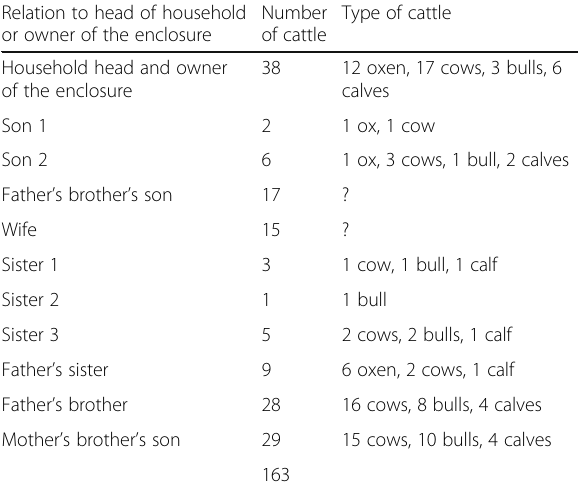
geared towards facilitating cattle transactions. The seller Table 3 Ownership relations in one homestead herd in